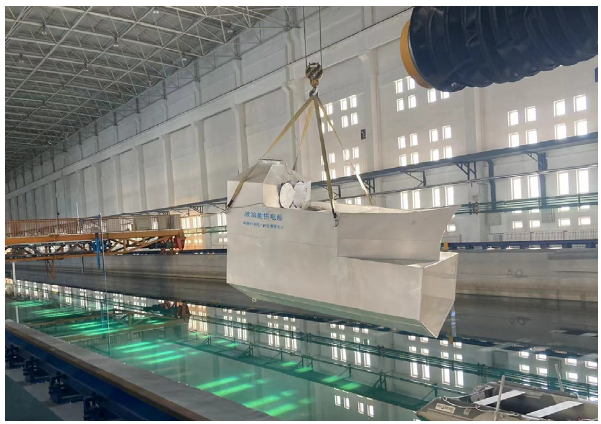
Figure 1. BBDB wave energy converter model with horn type.